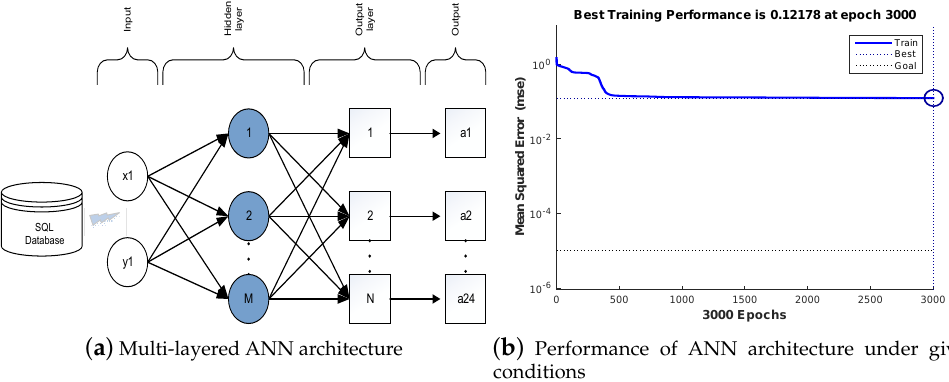
Figure 6. The considered architecture of the artificial neural network (ANN) and its performance in terms of error and